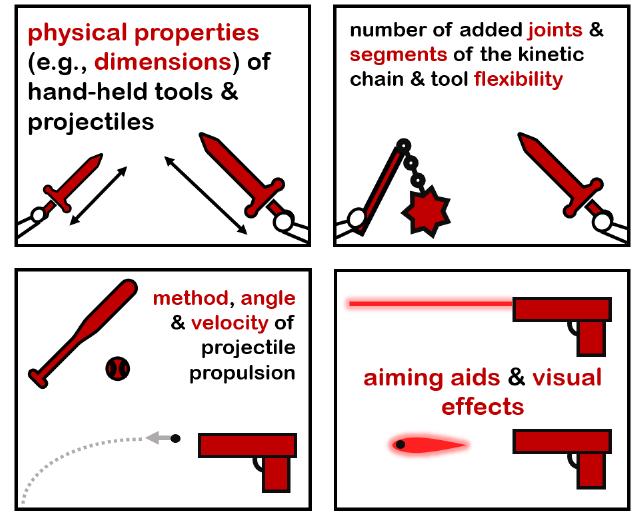
Figure 11. Examples of tool-related